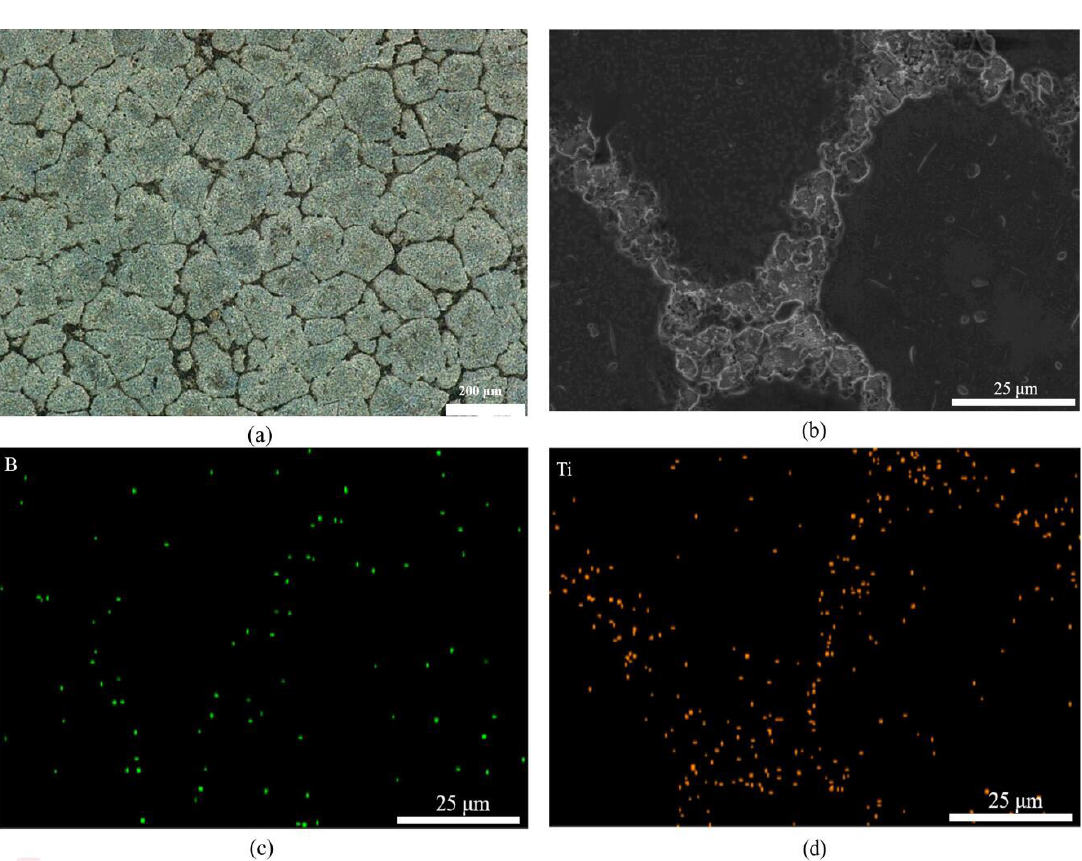
Figure 1. (a) the OM microstructure; (b) the SEM microstructure; the EDS mapping of (c) B and (d) Ti